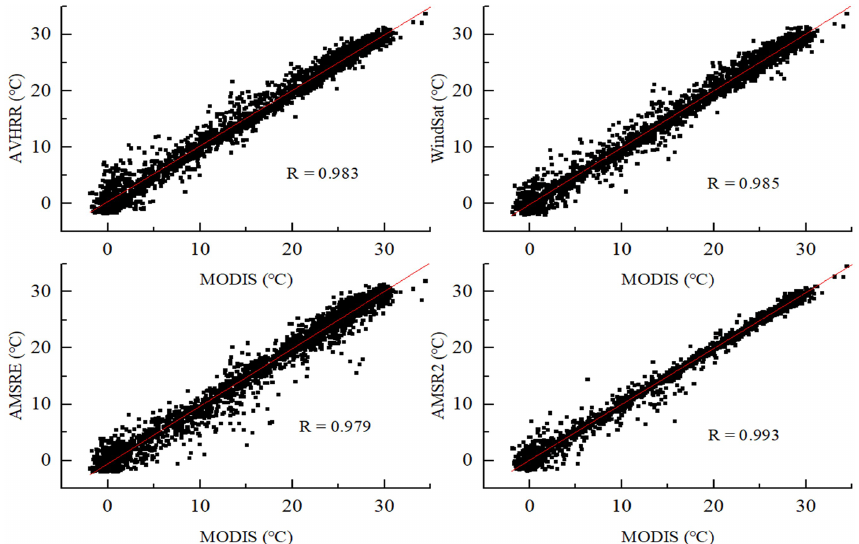
Figure 5. Scatter diagrams of the MODIS SST data and ocean multisource data compensated for different measurement times and effective sampling